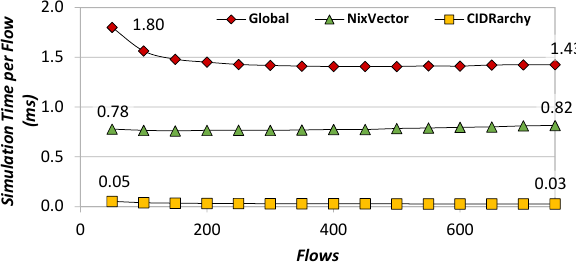
Figure 6: Simulation time per flow required by CIDRar- chy, Ipv4GlobalRouting and Ipv4NixVectorRouting rout- ing protocols to transmit flows of 1500 packets, each having a size of 1000 bytes, using OnOffApplication (left branch) and PacketSink (right branch) applications, in a balanced tree topology with 1500 hosts in each branch (3000 hosts total), for an increasing number of